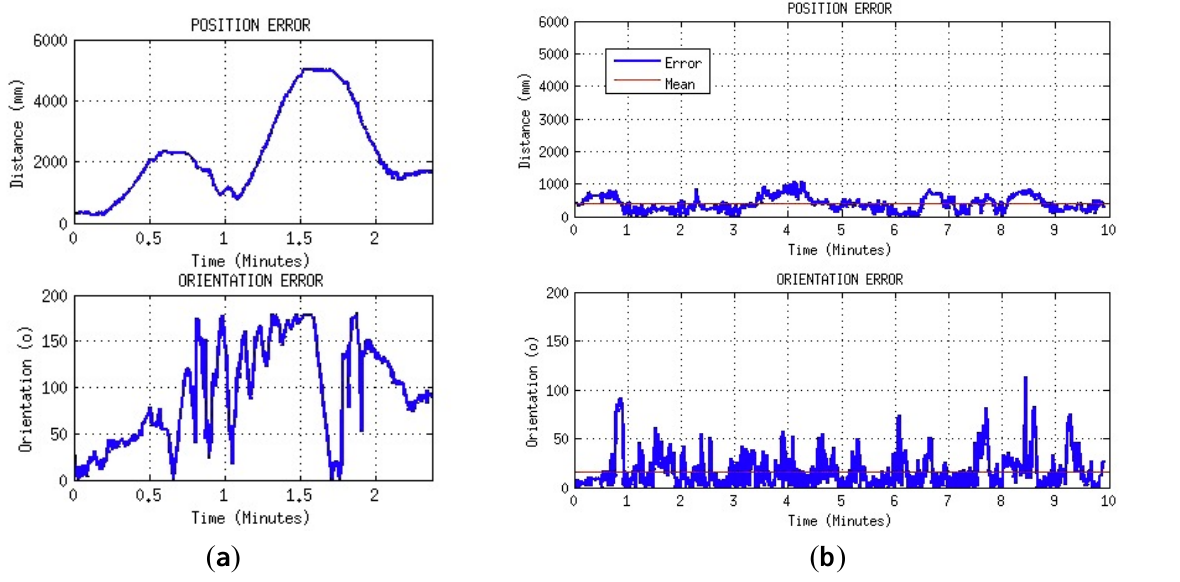
Figure 21. Localization tests result using: ( a ) Odometry-based system. ( b ) Modified particle filter localization